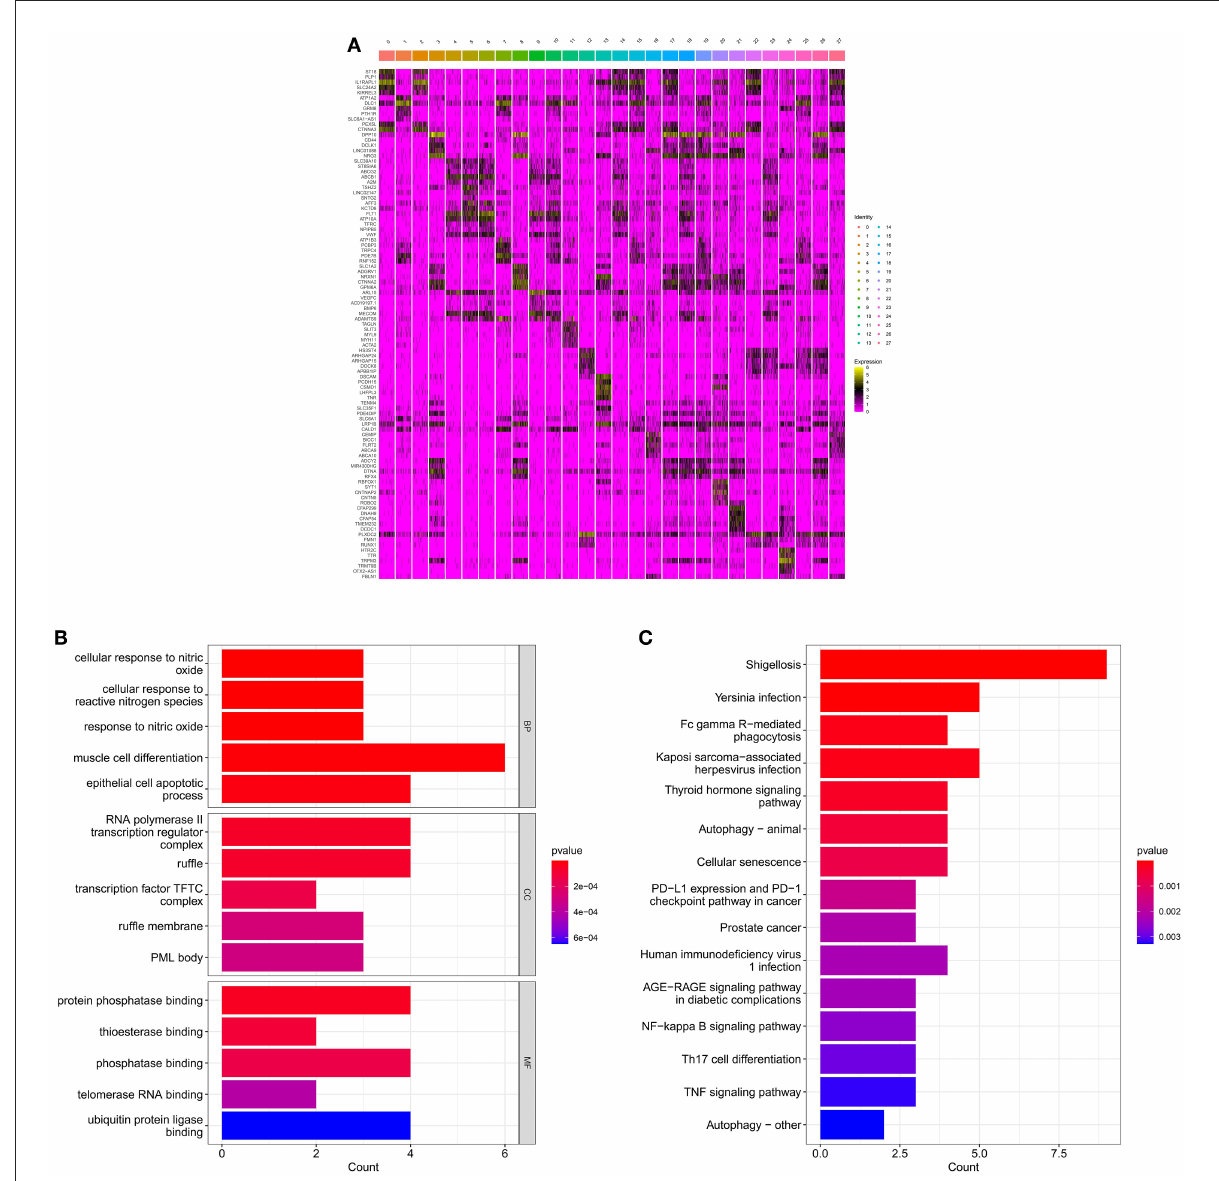
FIGURE3 Enrichment analysis for the identification of markers genes. (A) Heat map demonstrating the distribution of marker genes. (B) Histogram of GO enrichment analysis of marker genes. (C) Histogram of KEGG functional analysis of marker